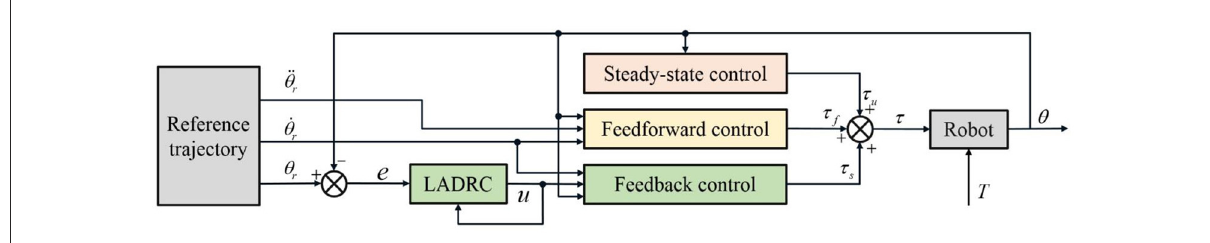
FIGURE2 Control framework of the triple-step controller with LADRC.